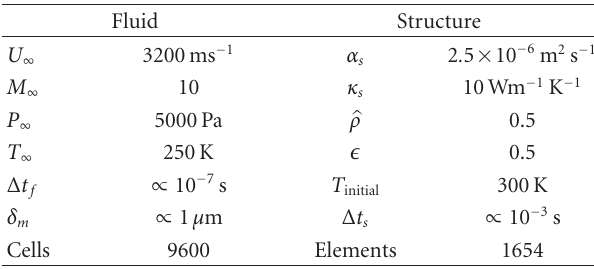
Table 1: Cone head simulation